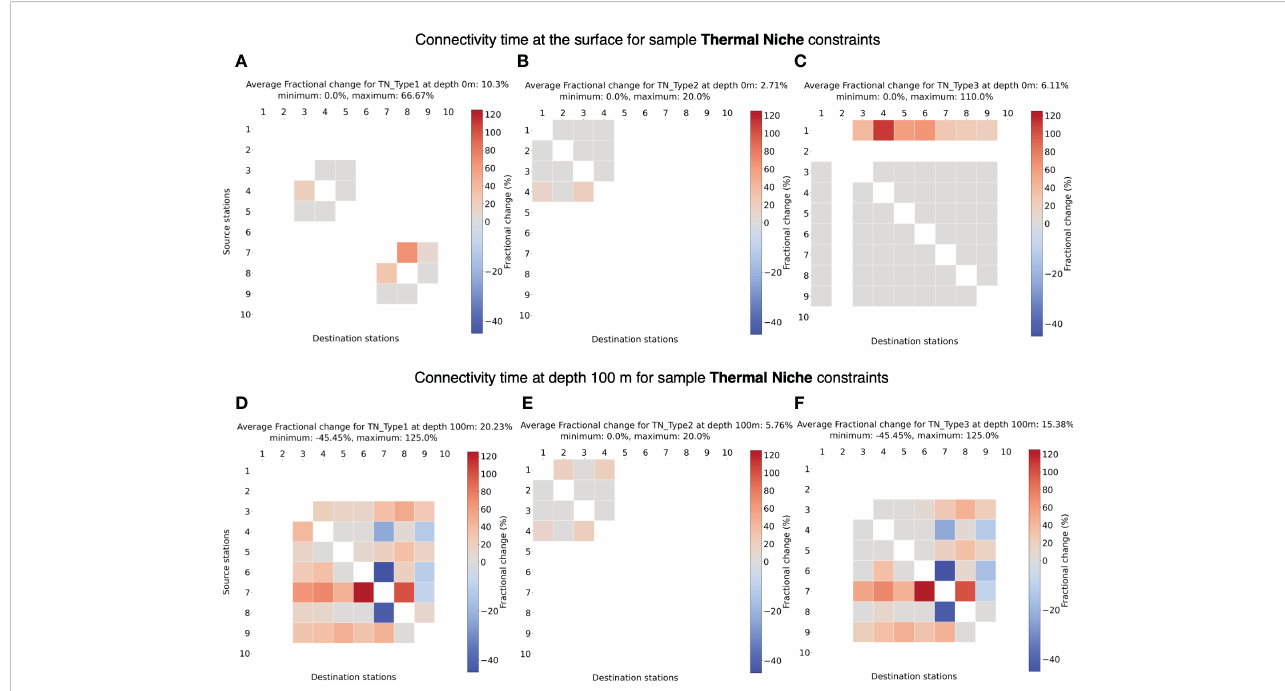
FIGURE 8 (A-C) Fractional change in minimum connectivity time at the surface compared to the non-constrained surface connectivity case in Figure 4A for sample thermal niches TN Type 1-3 . (D-F) Fractional change in connectivity time at depth 100 m compared to the non-constrained surface connectivity case in Figure 4A for sample thermal niche constraints TN Type1-3 . The details of these niches are listed in Table 2. The stations are in the ascending order of their latitudes.